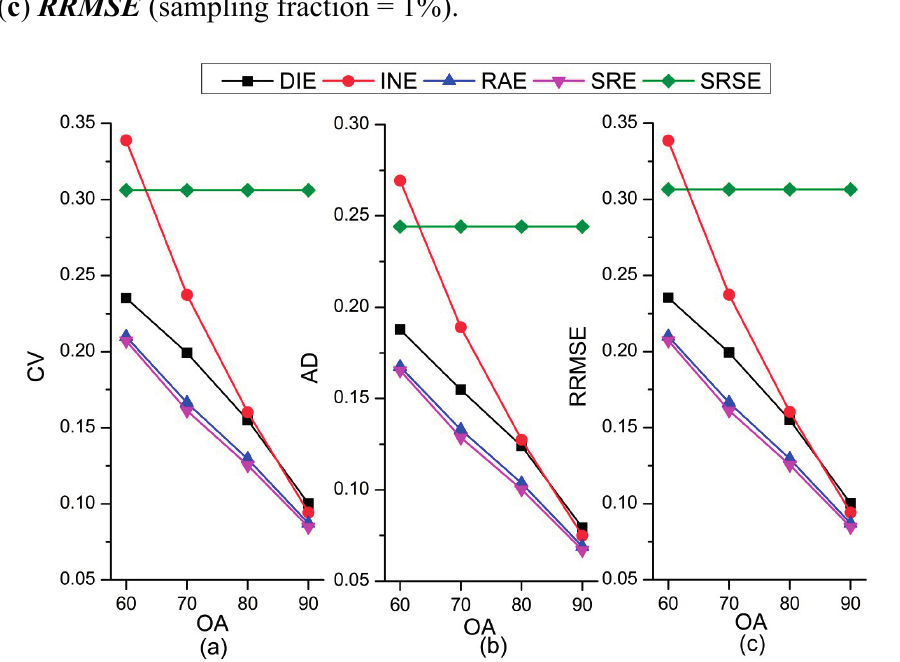
Figure 5. Comparison of estimators at various classification accuracy levels. ( a ) CV , ( b ) AD , ( c ) RRMSE (sampling fraction =